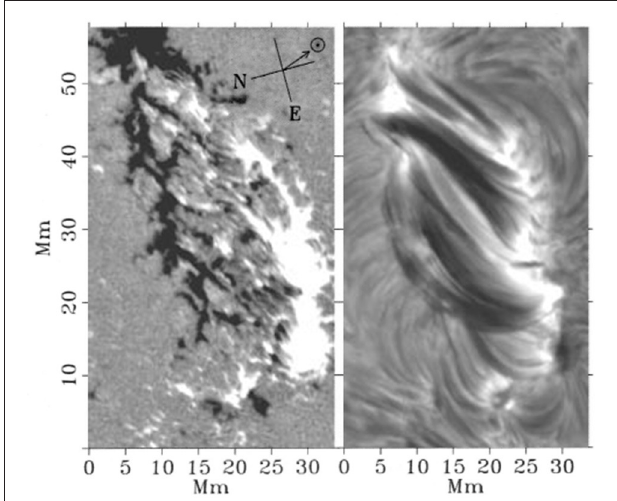
FIGURE 2 | The newest appearing elementary bipoles (eBiPs) are pairs of tiny black and white dots that are slightly elongated in the direction of motion. Most of the white, positive-polarity eBiPs move SE while most of the black ones move NW directly away from their corresponding white pole. Apparent reversals to this pattern are those in which an eBiP is cancelling (disappearing by reconnection) with a neighboring eBiP of opposite polarity. On the right is a corresponding H α image showing dark arch filaments that span pairs of eBiPs of opposite polarity. Illustration from Strous and Zwaan (1999) using images they recorded at the Swedish Solar Observatory on 1989 July 29. © AAS. Reproduced with